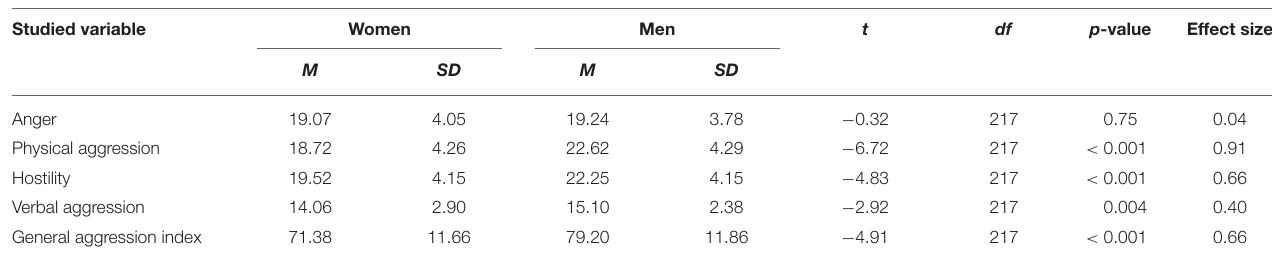
TABLE 4 | Comparison of the level of aggression dimensions between women and men. Studied variable